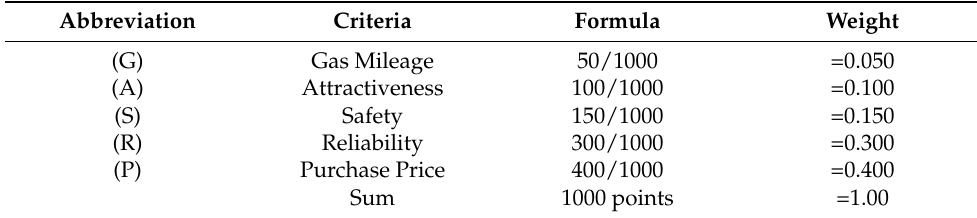
Table 5. Weight calculation for